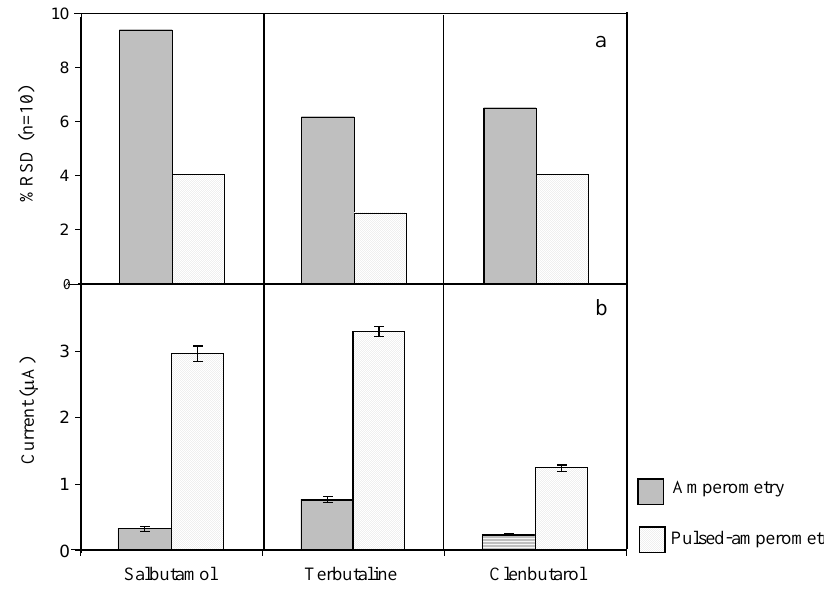
Figure 5. Significant improvement in both precision (a) and signal size (b) upon employment of pulsed amperometry with BDD electrode. Results were from replicate injections